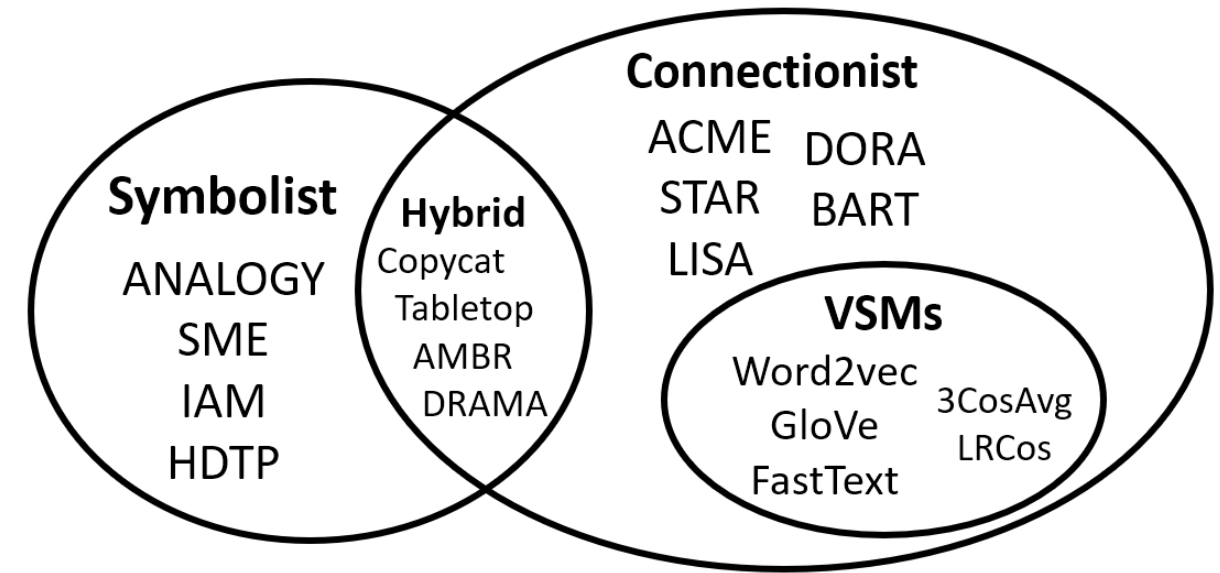
Figure 7. Taxonomy of symbolist, connectionist, and hybrid analogical inference algorithms (adapted with permission from Ref. [59]. 2022, Combs et al.).